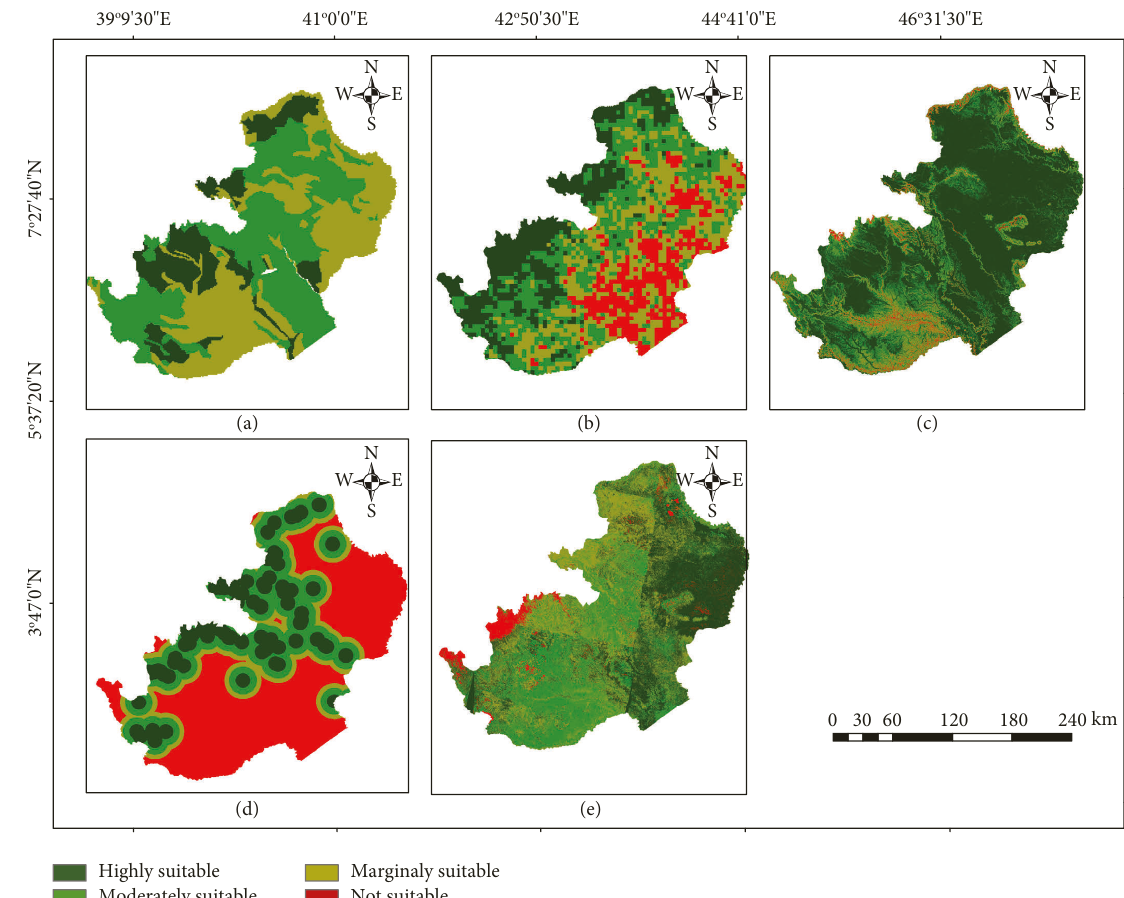
Figure 8: Factor suitability map for cattle mobility: (a) soil type, (b) rainfall, (c) slope, (d) water accessibility, and (e)